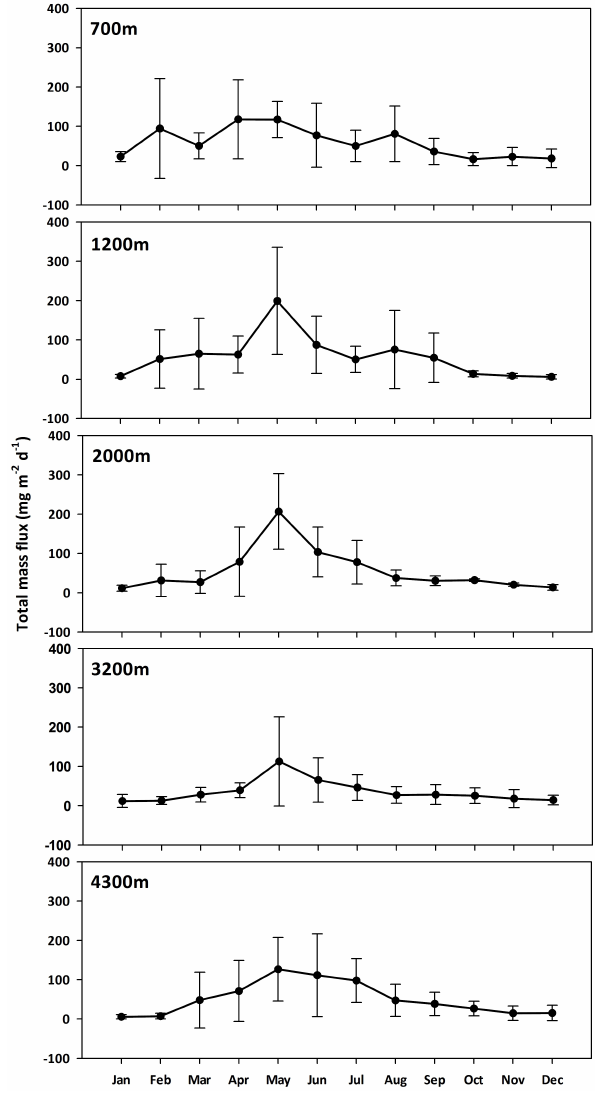
Fig. 5. Mean total mass fluxes ( ± 1std. dev.) of the entire four-year data set, where years were used as